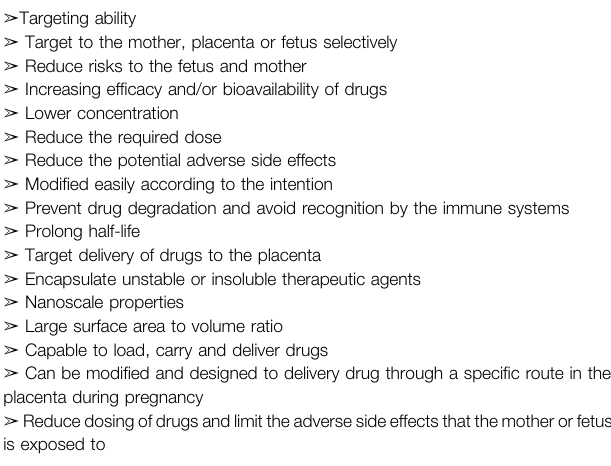
TABLE 2 | Characteristics of nanoparticles that would be bene fi cial in treating placental dysfunction. ➢ Targeting ability ➢ Target to the mother, placenta or fetus selectively ➢ Reduce risks to the fetus and mother ➢ Increasing ef fi cacy and/or bioavailability of drugs ➢ Lower concentration ➢ Reduce the required dose ➢ Reduce the potential adverse side effects ➢ Modi fi ed easily according to the intention ➢ Prevent drug degradation and avoid recognition by the immune systems ➢ Prolong half-life ➢ Target delivery of drugs to the placenta ➢ Encapsulate unstable or insoluble therapeutic